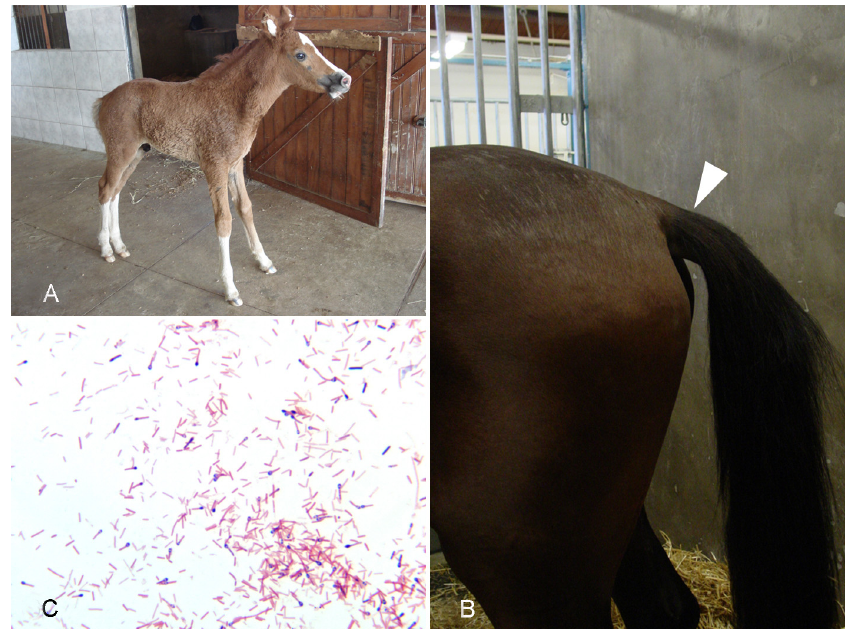
Figure 6. Tetanus. ( A ) Foal showing muscle stiffness resulting in a “rocking horse” stance and lock-jaw (photo courtesy of Francisco Lobato). ( B ) Adult horse; the tail is held out (arrowhead; hoto courtesy of Nicola Pusterla). ( C ) Smear of Clostridium tetani culture showing Gram-positive rods with terminal spores giving them the typical drumstick appearance; notice that the Gram positivity has been lost in some of these rods. Gram stain.